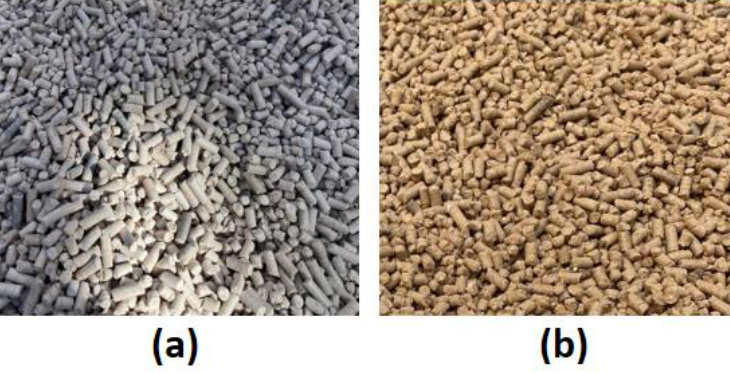
Figure 1. Selected formed pellets: ( a ) S90, ( b ) B90.